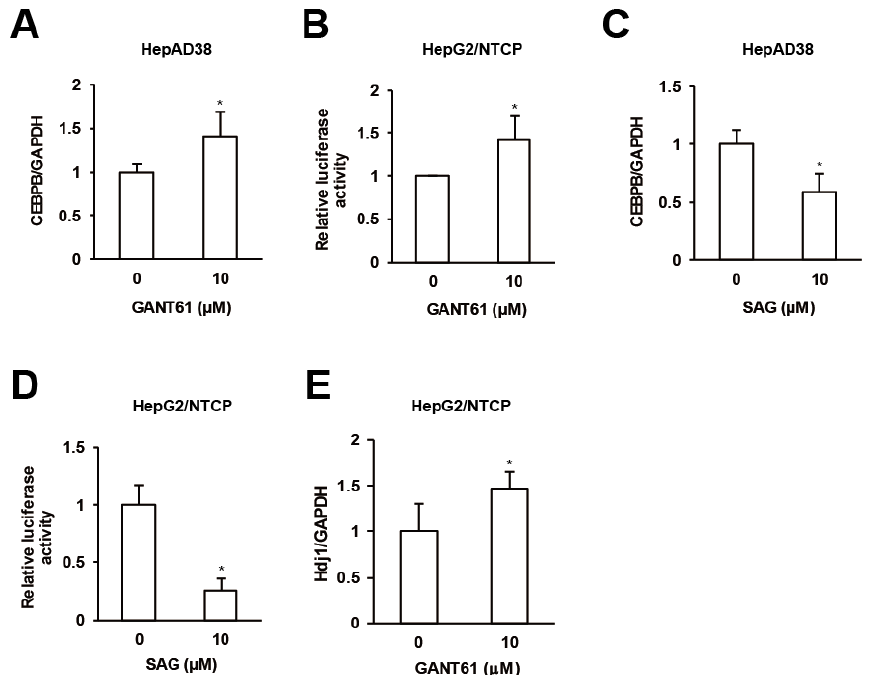
Figure 5. Crosstalks orchestrated by GPR39. ( A ) The e ff ect of GANT61 on CEBPB expression. After the treatment of HepG2 / NTCP cells with GANT61 at 10 µ M for 2 days, the relative mRNA levels were measured by qRT-PCR. ( B ) The e ff ect of GANT61 signaling on HSR. HepG2 / NTCP cells were transfected with the reporter plasmid for HSE for 24 h, followed by the treatment with either GANT61 at 10 µ M for 24 h, and the relative luciferase activities were measured. ( C ) The e ff ect of SAG on CEBPB expression. As in ( A ), the cells were treated with SAG at 10 µ M and the relative mRNA levels were measured by qRT-PCR. ( D ) The e ff ect of SAG on HSR. As in ( B ), the cells transfected with the reporter plasmid for HSE were treated with SAG at 10 µ M, and the relative luciferase activities were measured. ( E ) The e ff ect of GANT61 on the expression of Hdj1. After the treatment of HepG2 / NTCP cells with GANT61 at 10 µ M for 2 days, the relative mRNA level of Hdj1 was measured by qRT-PCR. Statistical significances with p < 0.05 to controls were indicated by asterisks.